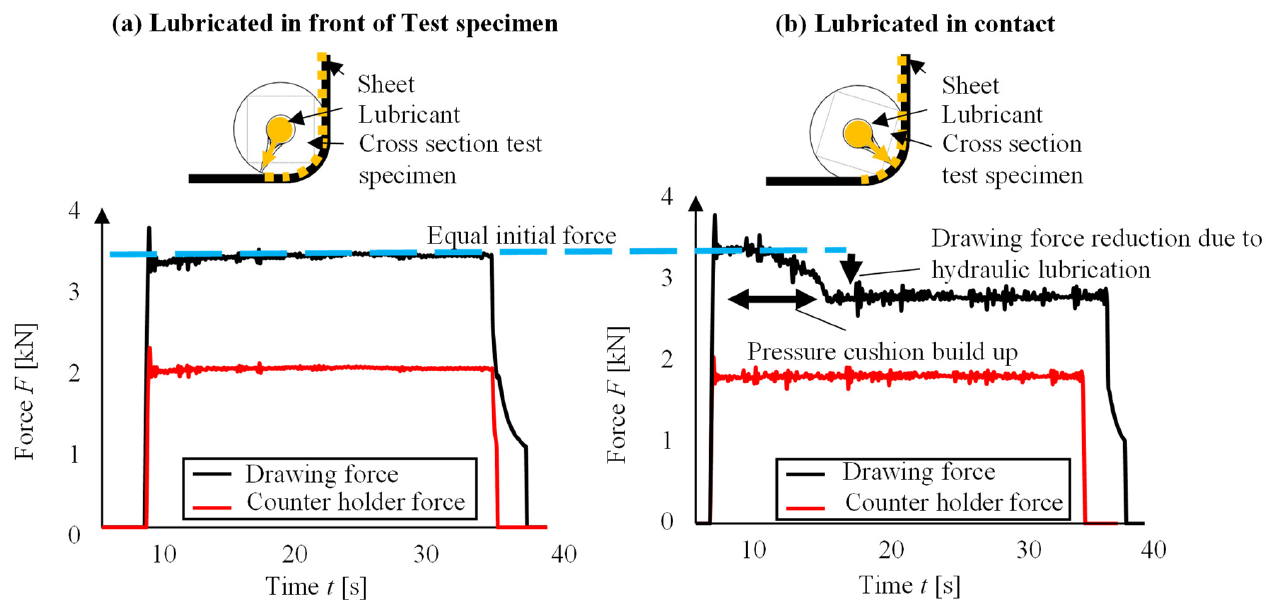
Figure 17. Force progression for in contact and in front of test specimen lubricated experiments.